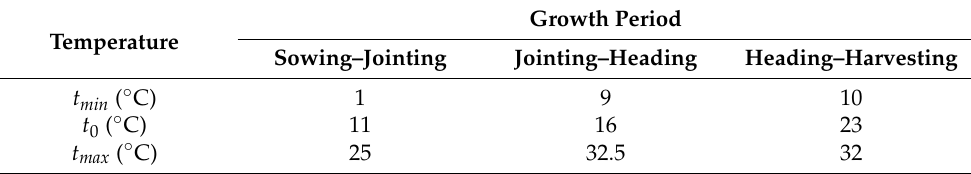
Table 2. Minimum ( t min ), optimum ( t s ), and maximum ( t max ) temperatures for each winter wheat developmental